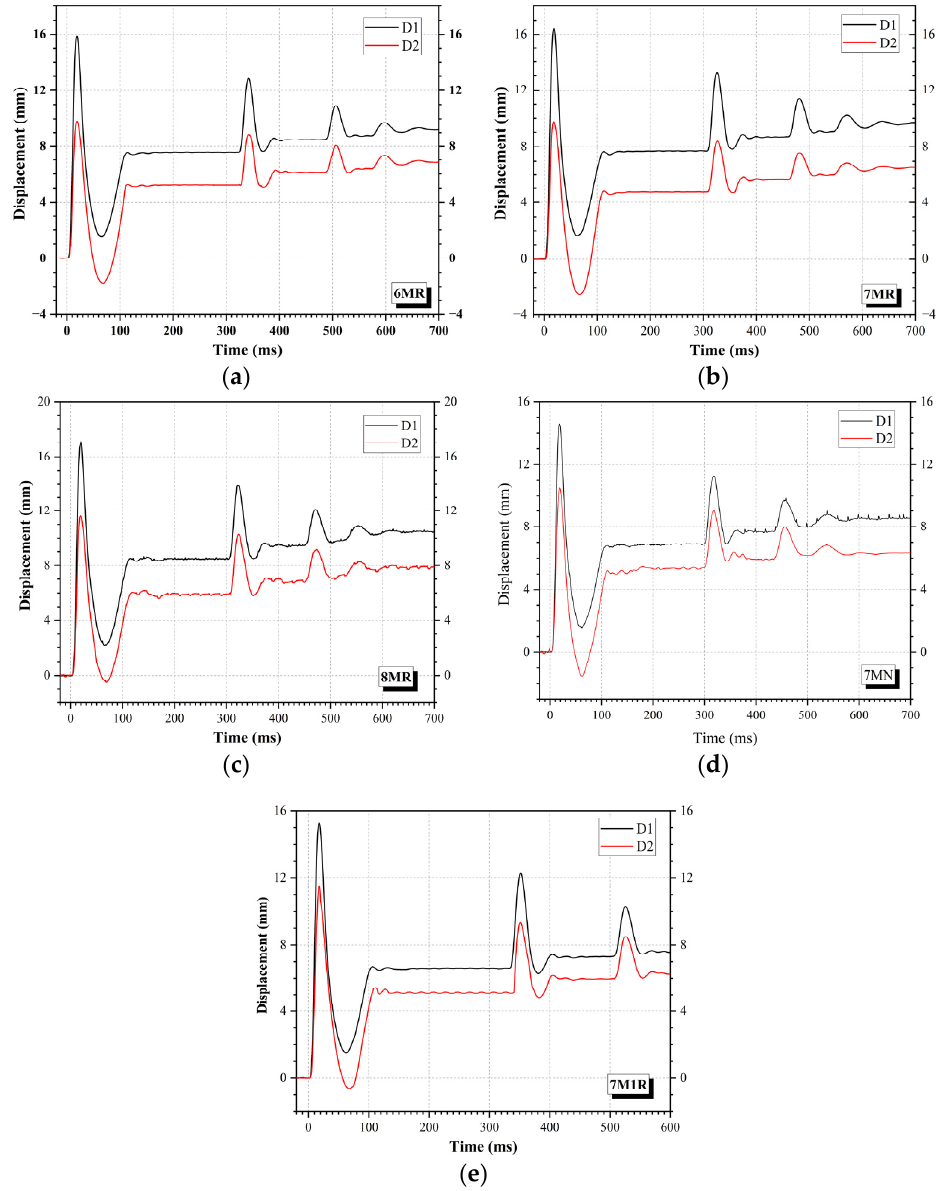
Figure 11. Displacement -time histories of the ( a ) 6MR specimen, ( b ) 7MR specimen, ( c ) 8MR specimen, ( d ) 7MN specimen, and ( e ) 7M1R specimen. Table 8. Displacement response of all tested specimens.